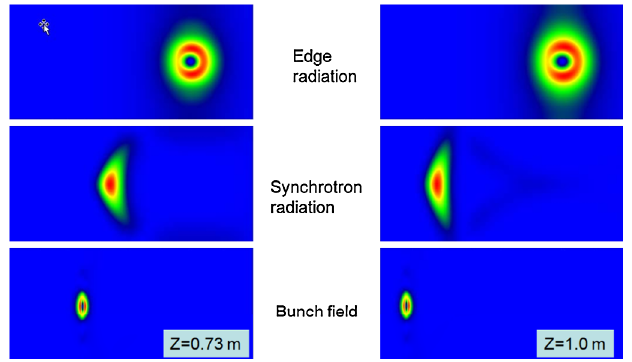
FIG. 12. Images of radiation in the form transverse magnetic field distributions. The left and the right sets of vertical plots correspond to different longitudinal positions. Each plot in a set shows a distribution at a different time. First comes an image of edge radiation, then the image of synchrotron radiation, and finally a bunch field